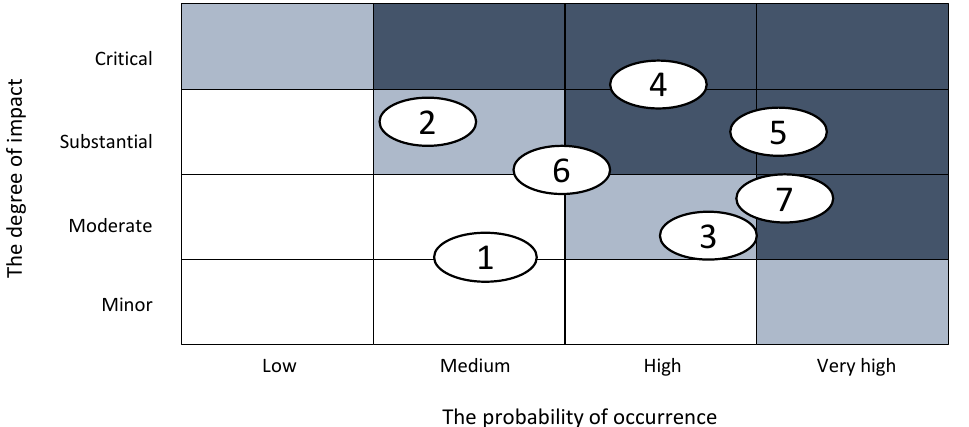
Figure 1. The risk assessment matrix of implementation of a